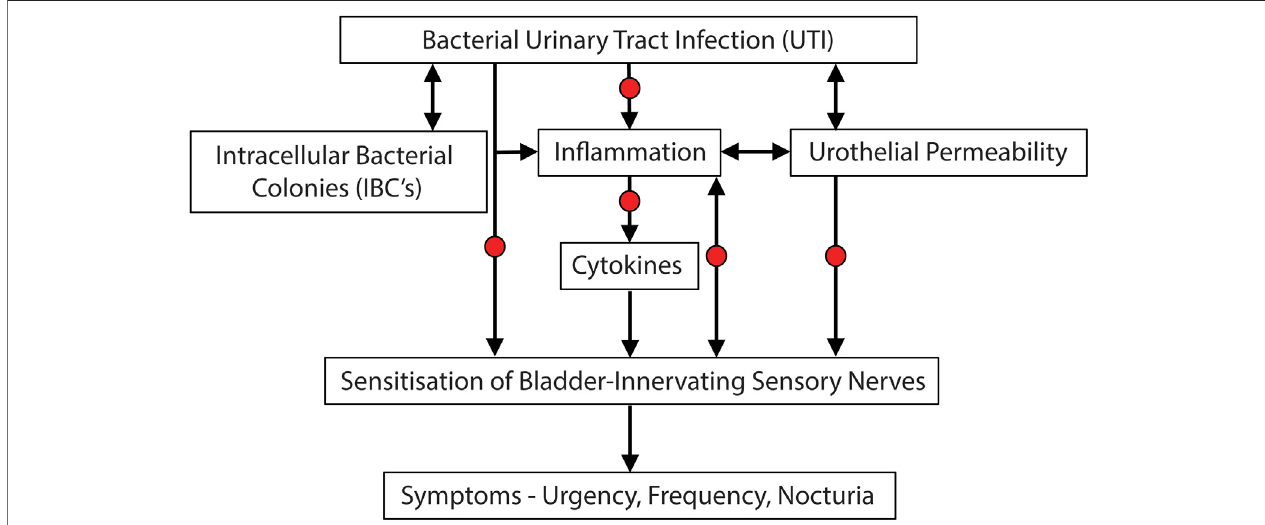
FIGURE3| PotentialetiologicalcascadeandpathogenesisunderlyingUTIinducedsymptomsofbladderhypersensitivity.Evidenceisaccumulatingthatsubsetsof OAB patients may in fact have an underlying bacterial infection, leading to in fl ammation and the sensitisation of bladder-innervating sensory nerves. Arrows represent causative links. Red dots represent potential opportunities for treatment of UTI induced OAB symptoms.